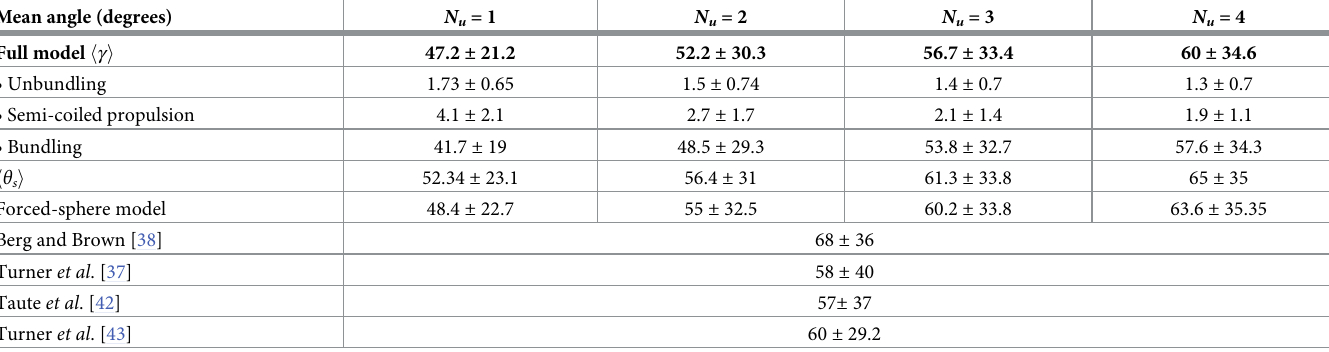
First row: mean angle h γ i given by full model and during each of the three stages of the tumble (unbundling; semi-coiled propulsion; bundling). Second row: mean angle h θ i between the original swimming direction and the direction of swimming during the semi-coiled propulsion (Eq (9)), and that predicted by the forced-sphere model. s Third row: mean reorientation angles in the experiments of Berg and Brown [38], Turner et al . [37], Taute et al . [42] and Turner et al . [43].